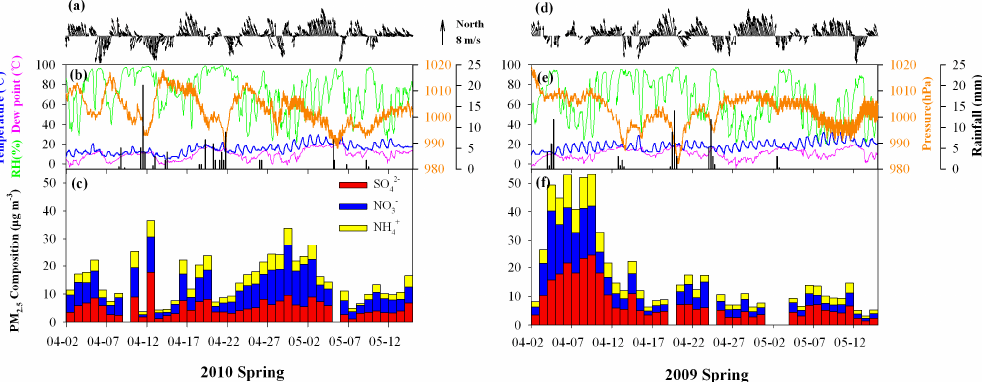
Fig. 4. ( a and d ) Hourly wind speed/direction; ( b and e ) atmospheric pressure, relatively humidity, dew point, temperature, and precipitation; ( c and f ) daily PM 2 . 5 inorganic secondary composition (i.e., SO 42- , NO 3- and NH 4+ ) concentrations during the spring in 2010 and 2009, respectively.